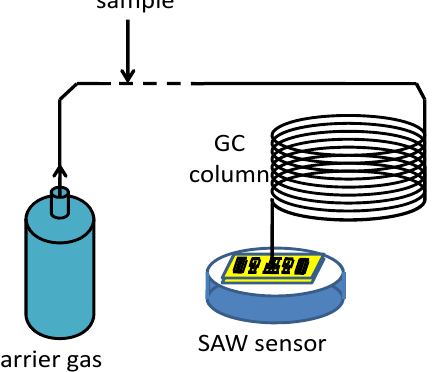
Figure 1. The schematic of the SAW gas sensor based on condensate-adsorption